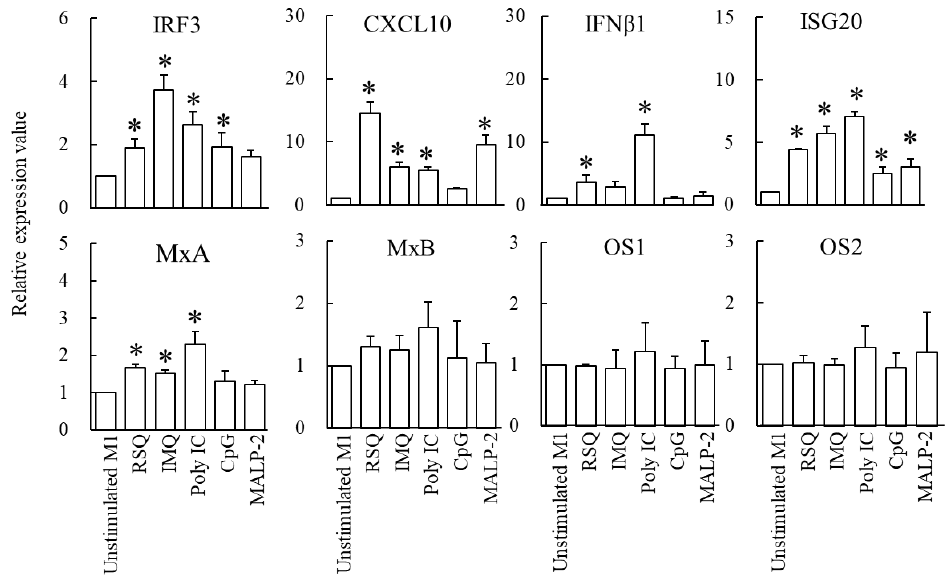
Figure 4. Effects of toll-like receptors (TLRs) ligands on the expression of antiviral genes in M1- phenotype macrophages. M1-phenotype macrophages were cultivated in the presence of phosphate- buffered saline (unstimulated M1) or TLR ligands (10 µ g/mL resiquimod, 10 µ g/mL imiquimod, 1 µ g/mL polyinosinic-polycytidylic acid, 20 nmol/mL CpG, or 100 ng/mL macrophage-activating lipopeptide-2) for 3 h. Quantitative real-time reverse transcription polymerase chain reaction assessed the relative expression values. The data are presented as the mean and SD ( n = 3). The comparison among multiple groups was evaluated using Dunnett’s posttest following ANOVA. * p < 0.05 (vs. unstimulated M1).